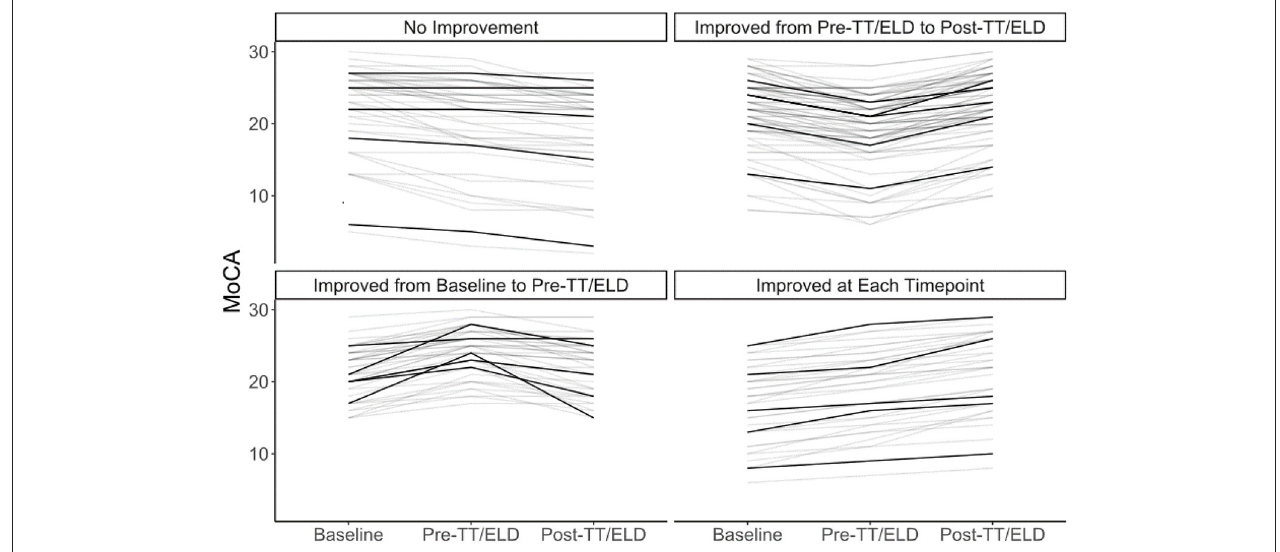
FIGURE 1 | Individual trajectories of MoCA at baseline, pre-TT/ELD, post-TT/ELD. 5 representative patients in each group identified in darker lines. No improvement ( n = 49). Improvement from pre to post-TT/ELD ( n = 90). Improvement from baseline to pre-TT/ELD ( n = 47). Improvement from baseline to pre-TT/ELD and pre to post-TT/ELD ( n =